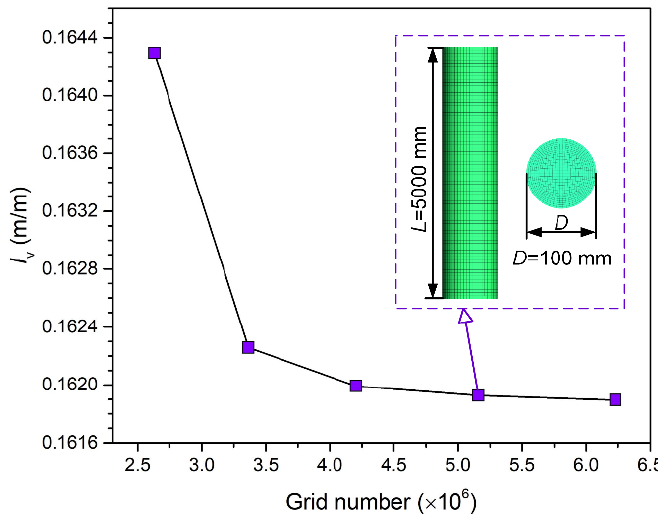
Figure 3. Variation of total pressure drop with total grid number. The numerically obtained total pressure drop of the flow with particles of d s = 15.0 mm was compared with the experimental result to examine the validity of the numerical scheme. More details regarding the experimental work can be found in [5]. The relationship between the total pressure drop and the initial mixture velocity in the vertical pipe is illustrated in Figure 4. It is evidenced that the numerical results agree well with the experimental data. As the initial mixture velocity increases, the total pressure drop increases, which is insensitive to the initial SVF. Furthermore, a high initial SVF is associated with a high total pressure drop. The maximum deviation between the numerical and experimental results is less than 5%, which proves high physical validity of the numerical scheme.